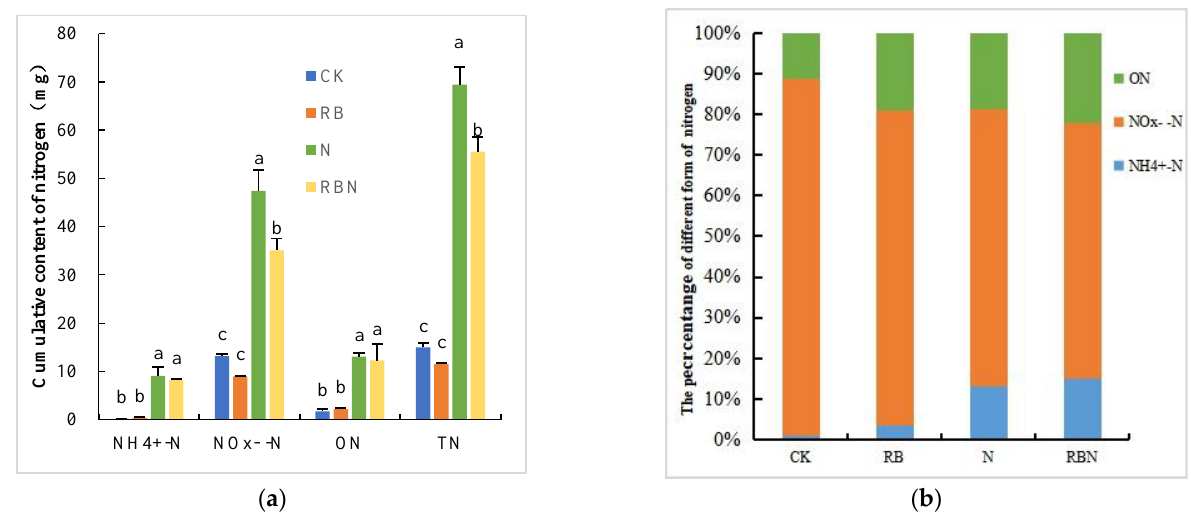
Figure 6. ( a ) Cumulative content of nitrogen; ( b ) the percentage of different forms of nitrogen. Different letters in the image ( a ) indicate significant differences between treatments ( p < 0.05).